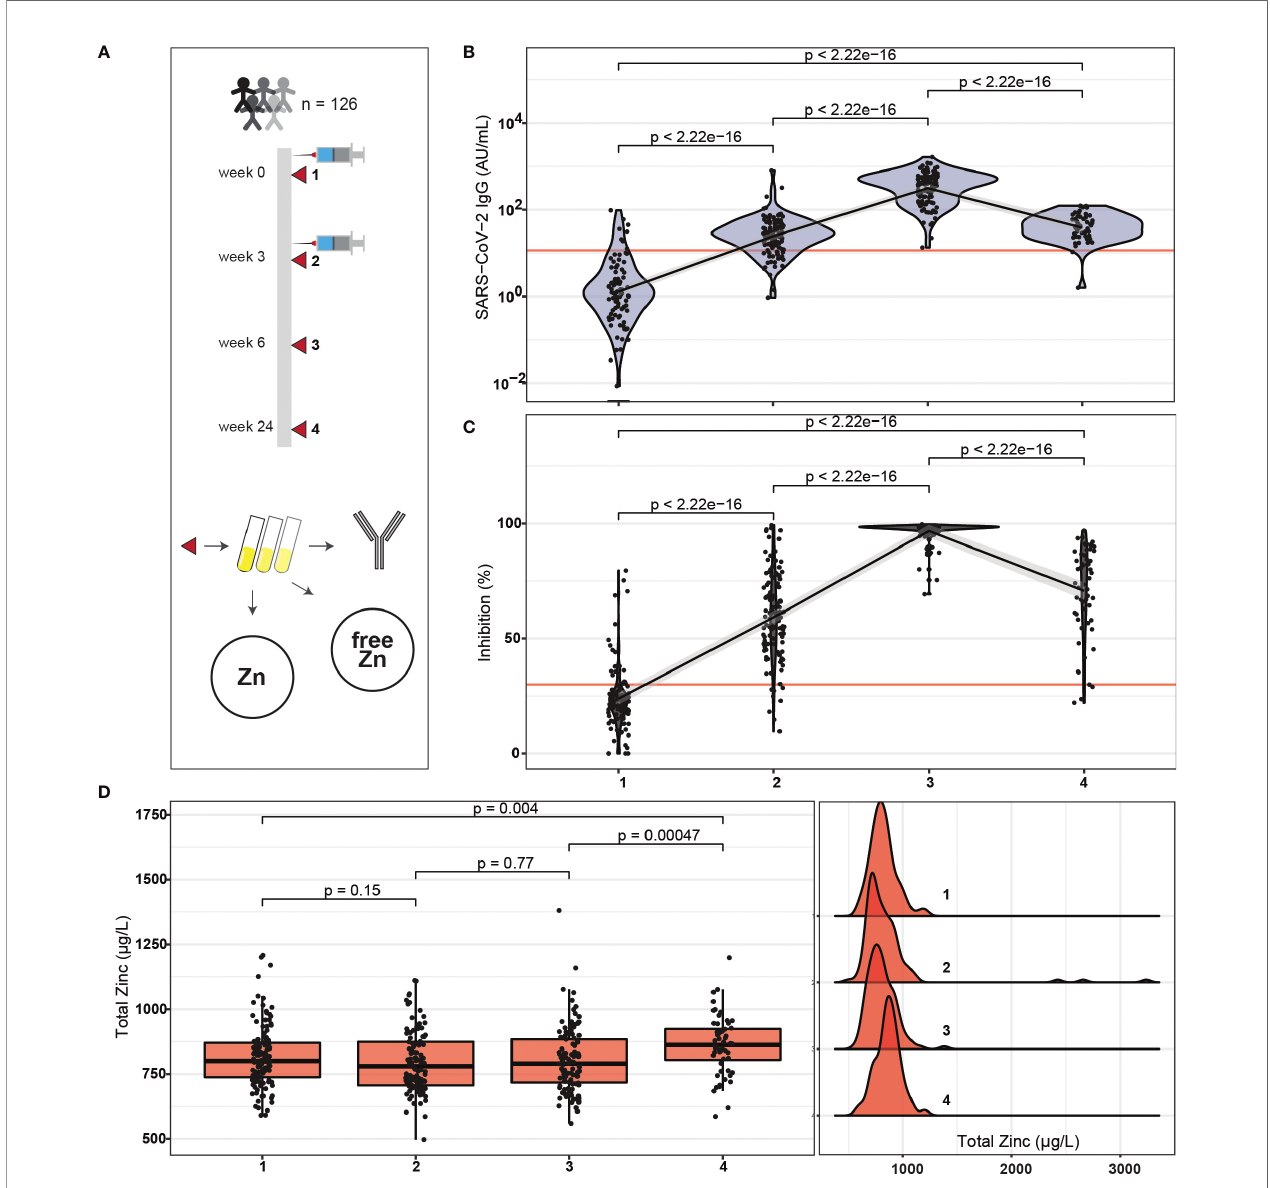
FIGURE 1 | Study design, SARS-CoV-2 antibody response and Zn status during the period of observation. (A) Healthy adult subjects received two doses of BNT162b2 vaccine within three weeks. Blood samples were collected on the days of vaccination, as well as three weeks and 21 weeks after second vaccination. The serum samples were analysed for SARS-CoV-2 antibodies, neutralizing activity, and total serum Zn as well as free Zn concentrations. (B) Total SARS-CoV-2 antibody concentrations increased from fi rst vaccination to a transient peak at three weeks after second vaccination, and declined thereafter. After six weeks, all participants reached seropositivity. (C) The serum samples showed neutralizing activities in parallel to SARS-COV-2 antibody concentrations, again with a transient peak at time point three, and with all participants passing the prede fi ned threshold of positivity (dark orange line). (D) Total Zn concentrations were similar during the fi rst three sampling points, but were slightly elevated at study end. All data points are shown including three samples with exceptionally high total serum Zn concentrations ( D , right hand panel). The data on SARS-CoV-2 antibodies (B, C) were presented earlier in relation to vitamin D and Se, and are provided here for orientation. Pairwise comparisons were conducted applying the Wilcoxon-Rank-Sum